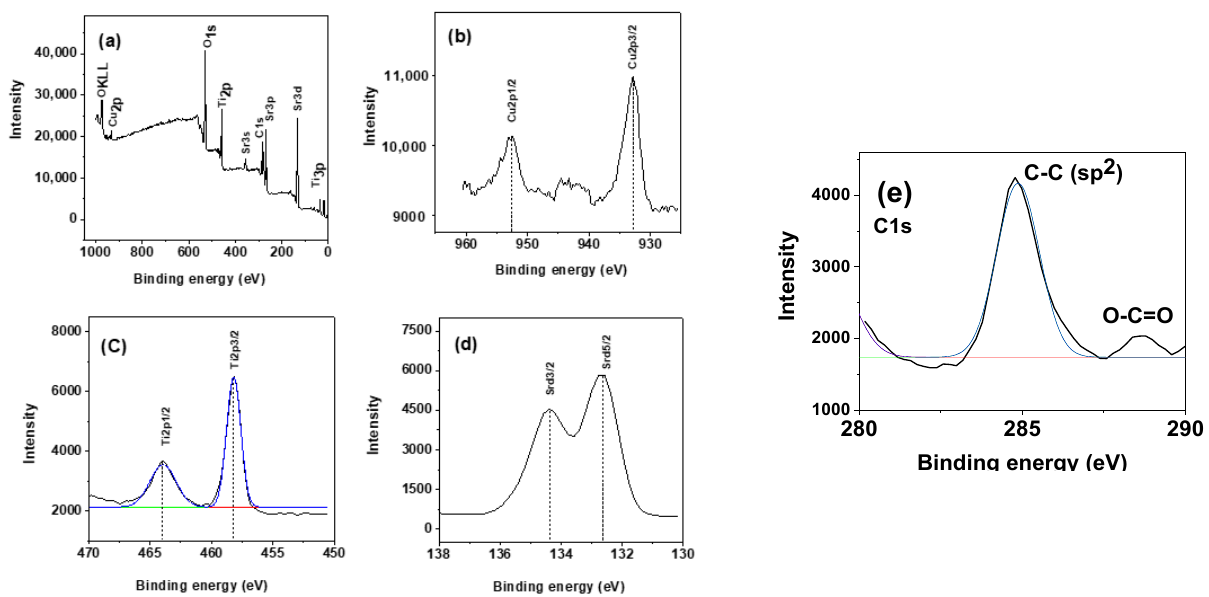
Figure 3. XPS survey spectra of 5% CuO/STO/MWCNTs ( a ), high-resolution spectra of Cu 2p ( b ), Ti 2p ( c ), Sr d spectra ( d ), and C 1s ( e ).